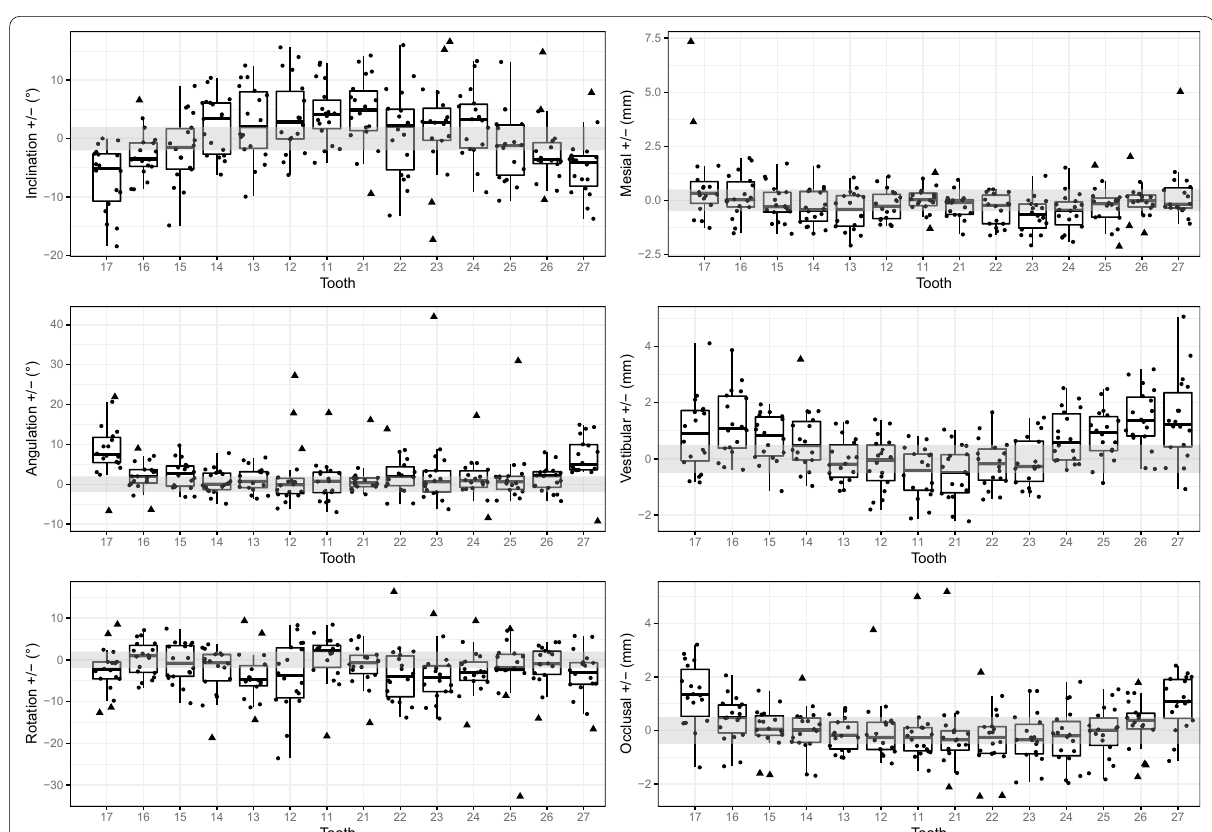
Fig. 2 Values of discrepancies of each tooth in the all three angles (inclination, angulation, rotation) and all three planes (mesial [sagittal], vestibular [transversal], occlusal [vertical]) between set-up and the situation after treatment. The grey rectangles define the “allowed” or “tolerable” areas according to Larson et al. [9]: 2.0° for angular and 0.5 mm for linear ± ±